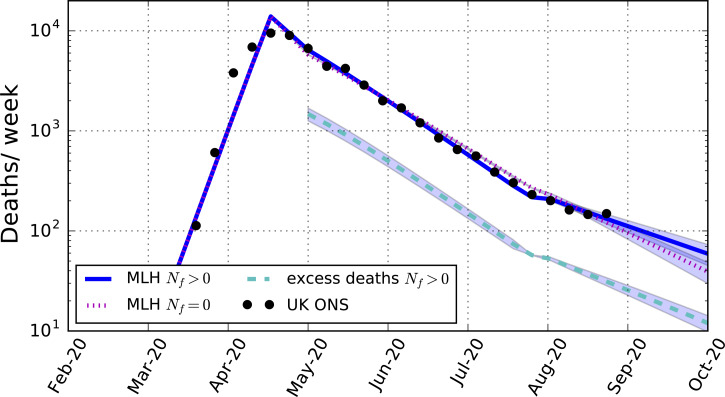
Predicted weekly death rates for the maximum-likelihood (MLH) model including fomite transmission (blue solid line, with 95% CI), excess deaths compared with a counterfactual model assuming the same reproduction numbers as for the maximum-likelihood model but without fomite transmission (cyan dashed-line, with 95% CI), and the maximum-likelihood model assuming no fomite transmission (magenta dotted-line, with 95% CI). The data points are the total weekly number of deaths in the UK due to COVID-19 as reported by the Office for National Statistics (Table 3).